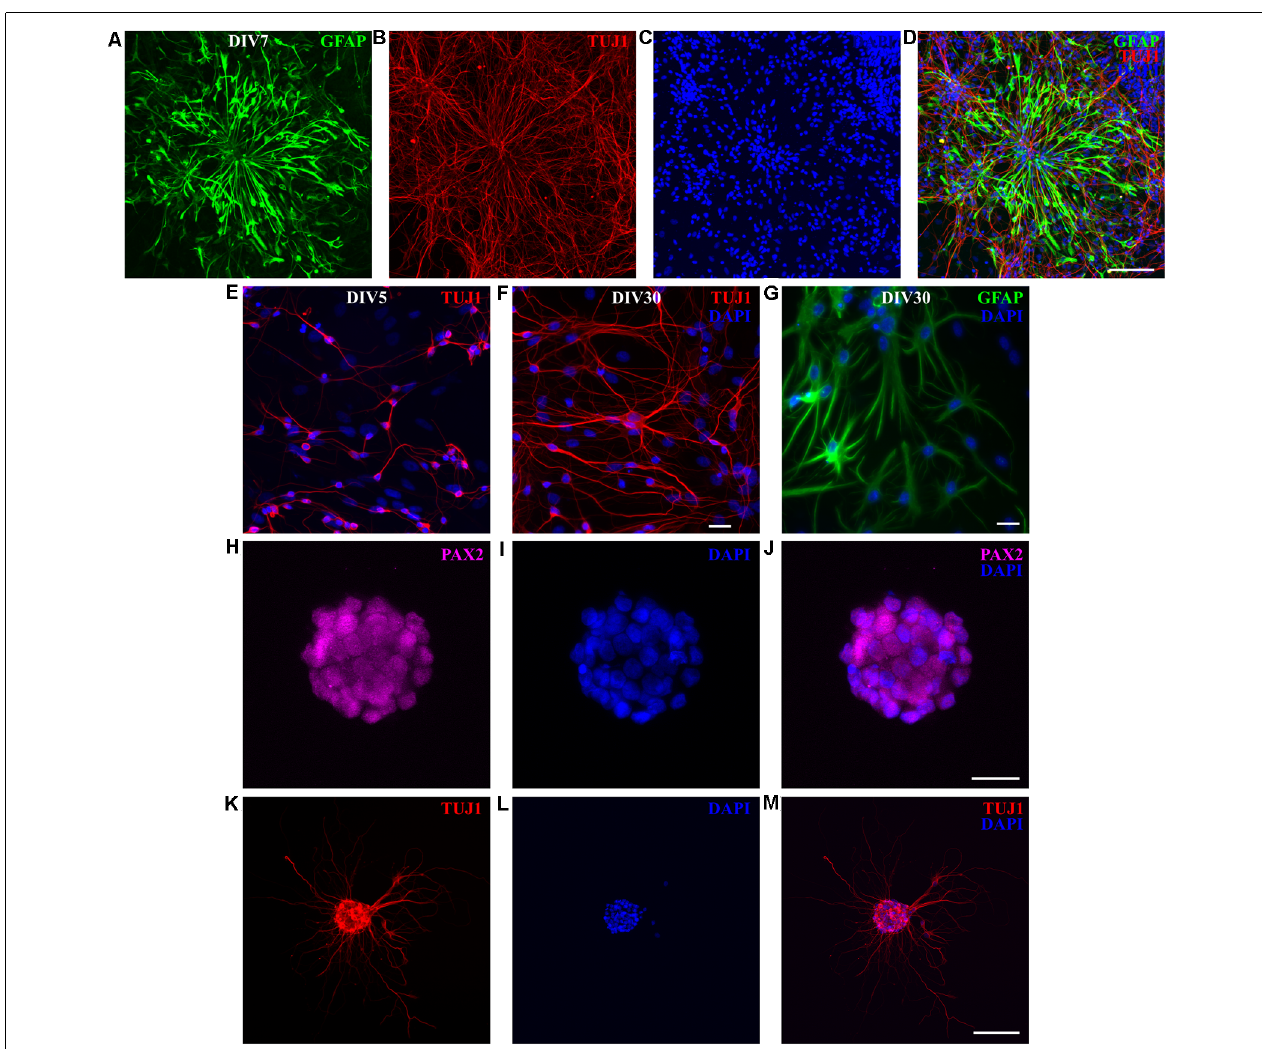
FIGURE 7 | P3 opossum-derived radial glial cells (RGCs) and neurospheres. (A) DIV7 primary cultures derived from P3 cortex stained for glial fibrillary acidic protein (GFAP, green), (B) TUJ1 (red), and (C) nuclear stain DAPI (blue). (D) Merged image. Scale bar, 100 µ m. Neuronal cultures (E) 5 and (F) 30 days after replating, stained for TUJ1 (red) and DAPI (blue). (G) Same as (F) but for GFAP (green) and DAPI (blue). (H–M) Immunocytochemical characterization and development of neurospheres. (H–J) DIV7 neurospheres in proliferation-promoting medium, stained for PAX2 (magenta), DAPI (blue), and merge, respectively. Scale bar, 25 µ m. (K) DIV7 neurospheres attached on poly-L-ornithine- and laminin-coated glass coverslips and cultured in the serum-free neuronal medium for additional 7 days extend long processes and express TUJ1 (red). (L) Nuclear stain (DAPI, blue) and (M) merge. Scale bar, 100 µ